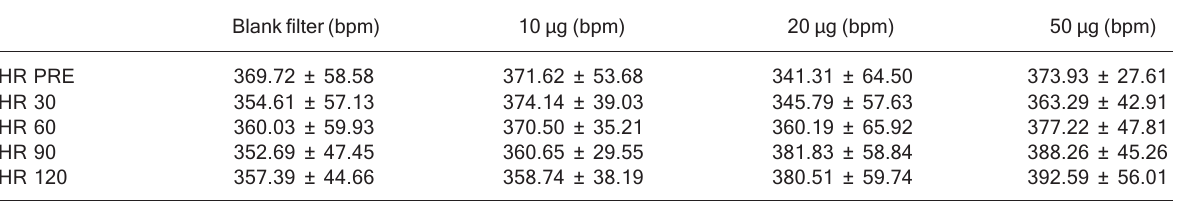
Table 3. Heart rate for all experimental groups immediately before (PRE) and at 30, 60, 90, and 120 min after tracheal instillation of PM 2.5 .